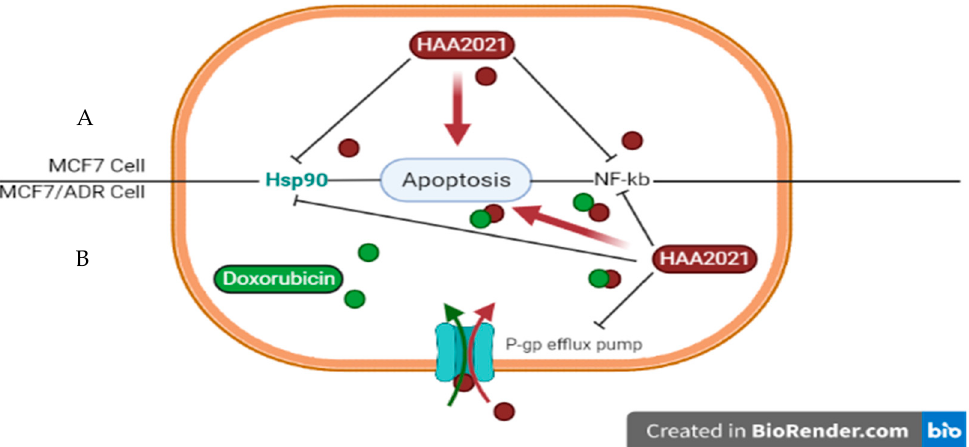
Figure 14. ( A ) HAA 2021 inhibits the expression of Hsp90 and NF-kB in MCF7 cells leading to apoptosis. ( B ) The chemosensitizing effect of HAA 2021 on MCF7/ADR cells to doxorubicin. The combination of HAA 2021 /doxorubicin enhances the doxorubicin-resistance, downregulates the P-gp protein synthesis and expression, and inhibits its efflux pump action, thus improving the accumulation of doxorubicin, and potentiating its targets on MCF7/ADR cells leading to apoptosis.